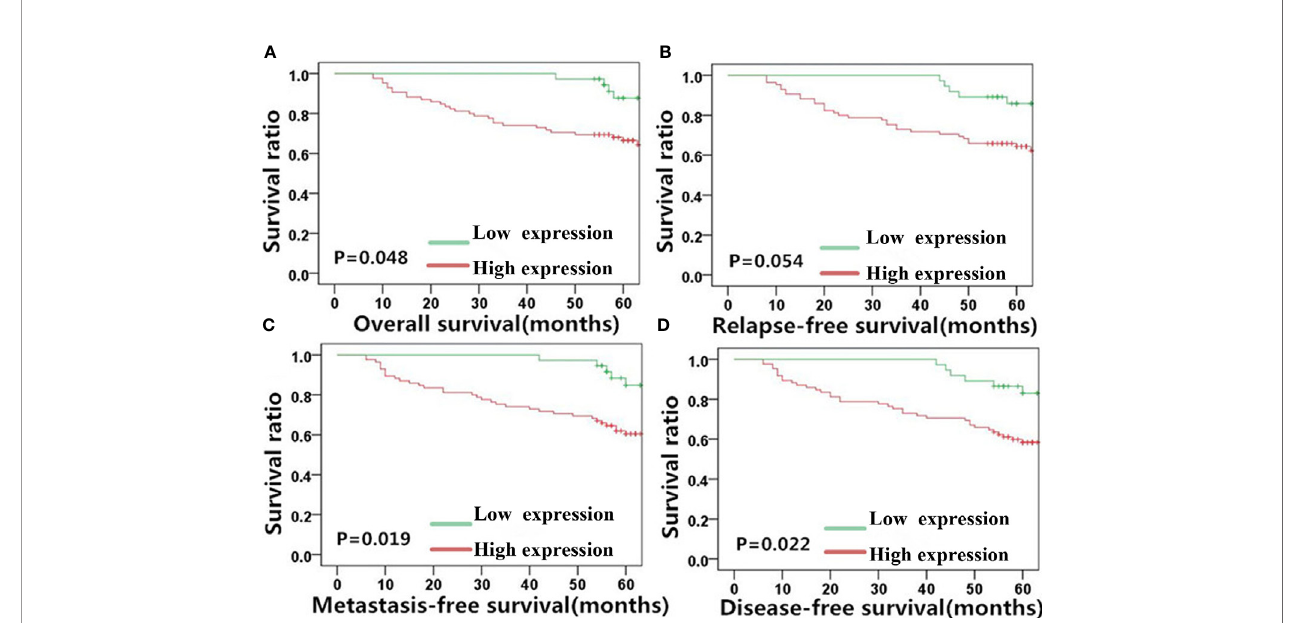
FIGURE 5 | Vimentin expression is signi fi cantly correlated with NPC patient survival outcome. Kaplan-Meier survival plots for (A) overall survival, (B) relapse-free survival, (C) metastasis-free survival, and (D) disease-free survival of the high (red lines) and low (green lines) vimentin expression groups. NPC, nasopharyngeal carcinoma.